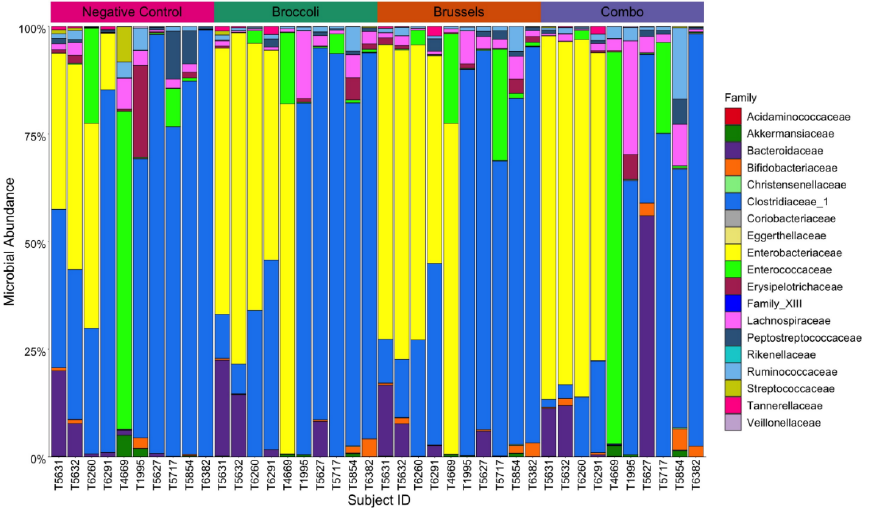
Figure 1. Alpha diversity is not impacted by incubation with in vitro digested cruciferous vegetables. Relative abundance of each family within the fecal culture ( n = 10). Each treatment group is listed above, and the color and size of each bar correspond to a different family and its relative abundance within each sample.